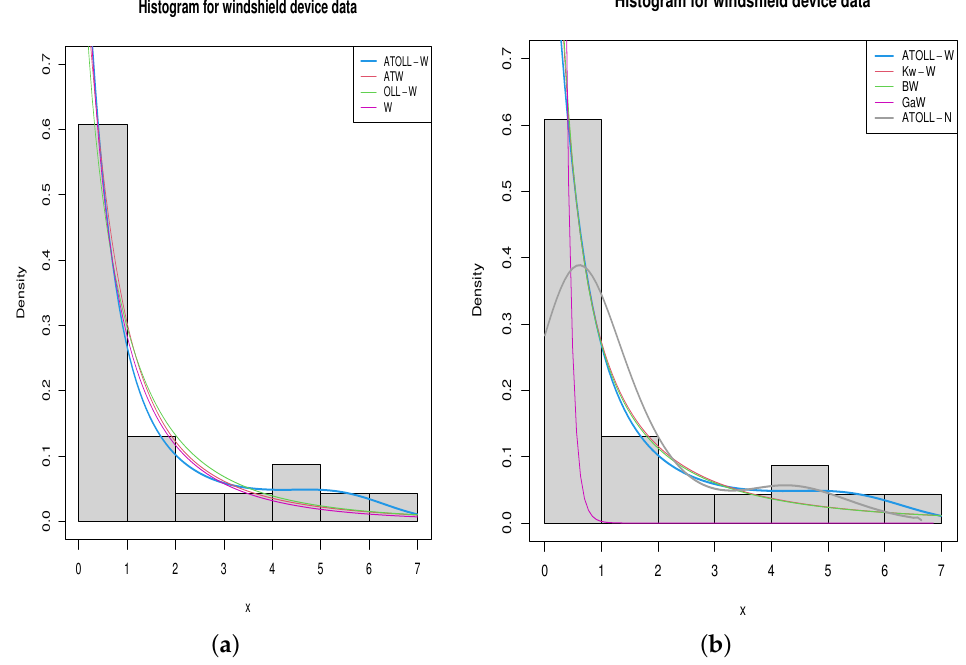
Figure 9. Histogram and density plots for windshield device data. Plots for ( a ) sub-models and ( b ) others